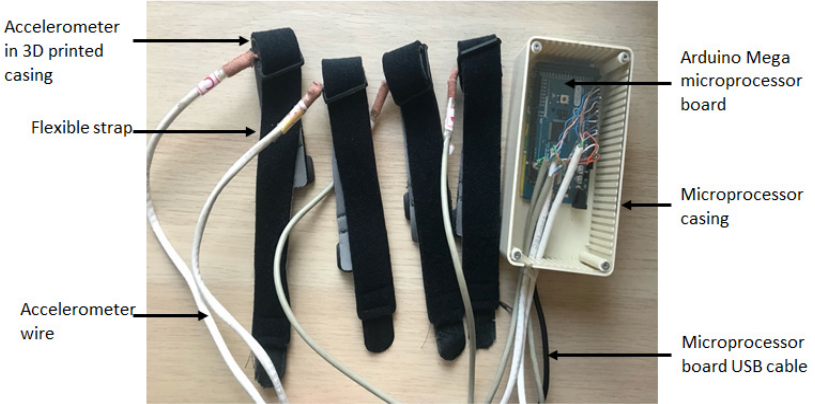
Figure 1. Accelerometry device used for data recordings. The microprocessor attached to the four accelerometers and flexible straps is shown.